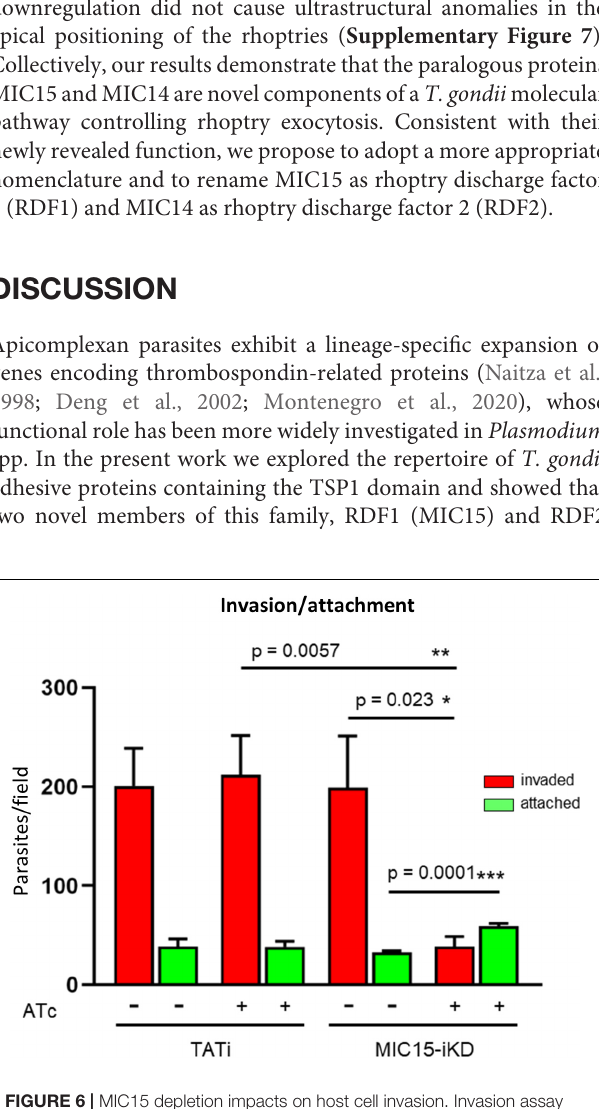
FIGURE 5 | the cytosolic (pellet) and excreted/secreted antigen (ESA) fractions of TATi and MIC15-iKD tachyzoites grown ± Atc for 60 h. The uncleaved (intracellular) and processed (extracellular) forms of the microneme proteins are indicated by arrows or arrowheads, respectively. GRA1 was used as loading control for the ESA fractions, while cytosolic proteins were normalized with either GRA1 or GAP45. (F) Gliding assay comparing the fraction of motile TATi and MIC15-iKD tachyzoites as revealed by the presence of SAG1 + posterior trails deposited on poly-Lysine-coated glass chamber slides. Prior to incubation on the substrate for 30 min, the two strains were grown for 60 h in presence or absence of Atc. (G) Egress assay estimating the capability of untreated or Atc-treated tachyzoites of strains TATi and MIC15-iKD to exit the parasitophorous vacuole upon stimulation with the calcium ionophore A23187. The data in panels F and G are expressed as mean values ± SEM from three independent experiments conducted in triplicate. In both assays, the Student’s two tailed t -test did not reveal statistically significant differences between strains irrespective of MIC15 depletion.